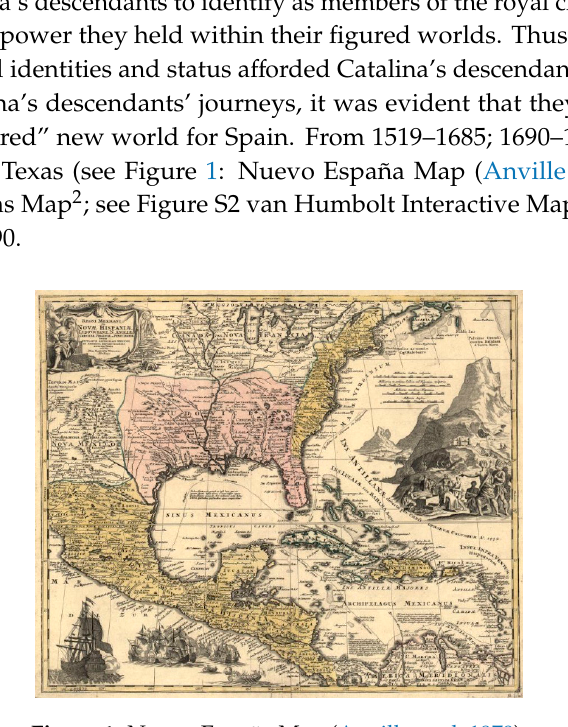
Figure 1. Nuevo España Map (Anville et al. 1979).